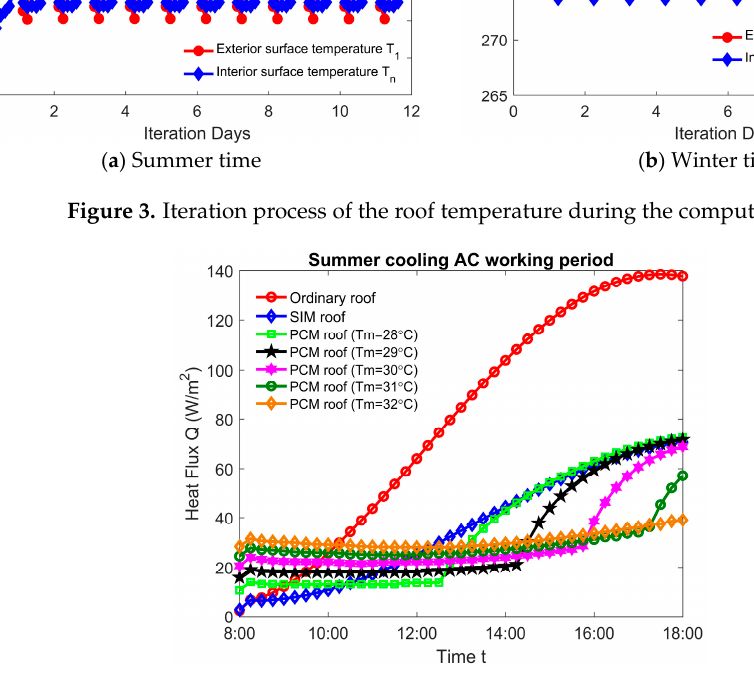
Figure 4. Heat flux magnitude of different types of roofs during the summer AC cooling time.